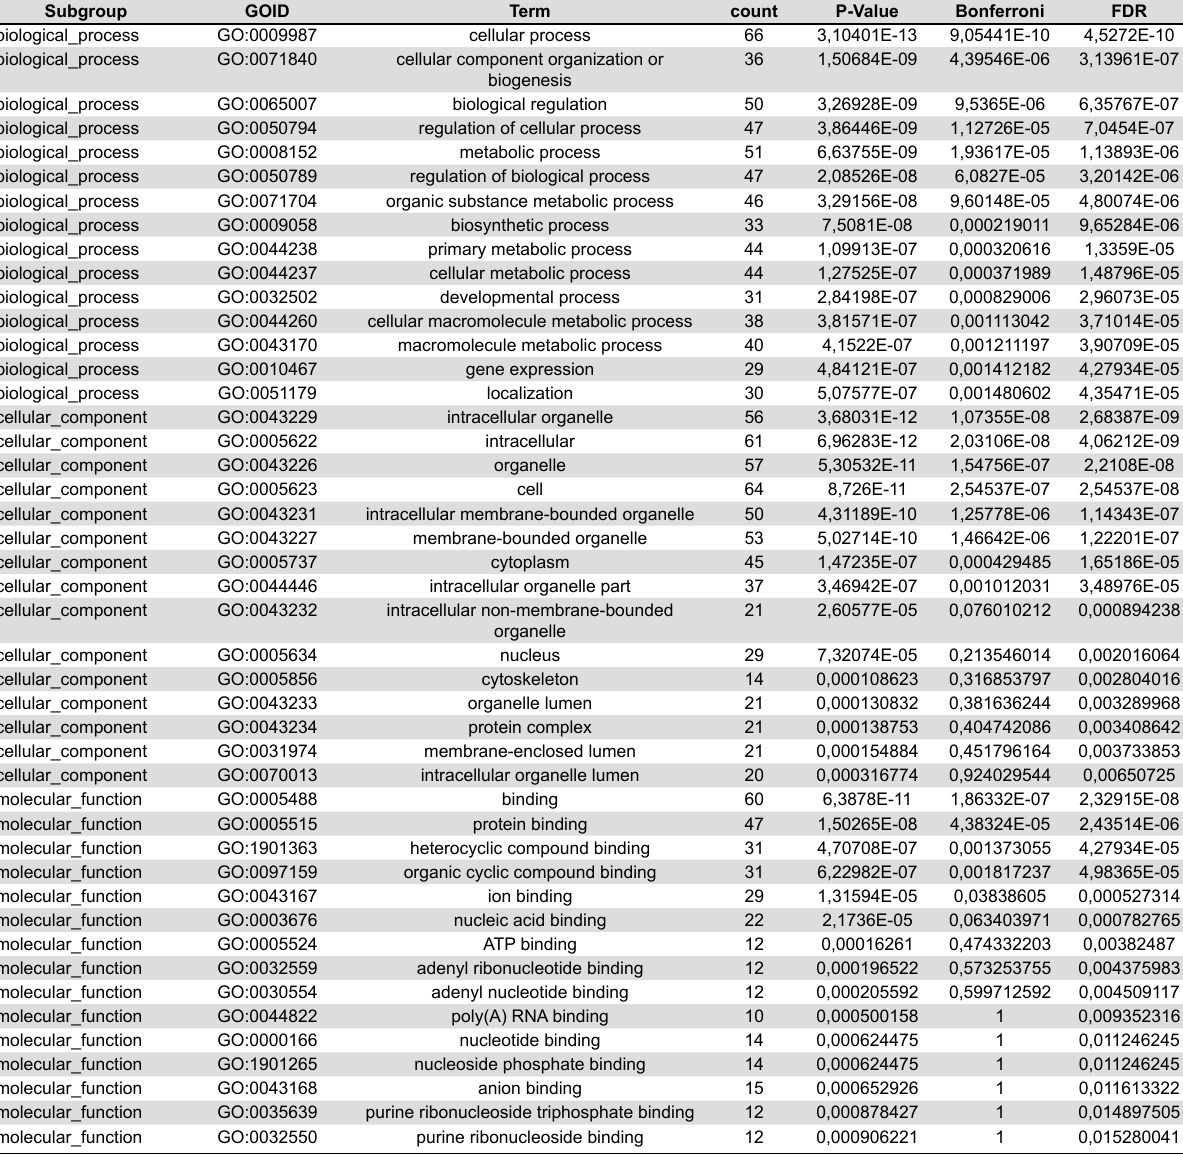
Table S3- The top 15 most enriched GO terms on day